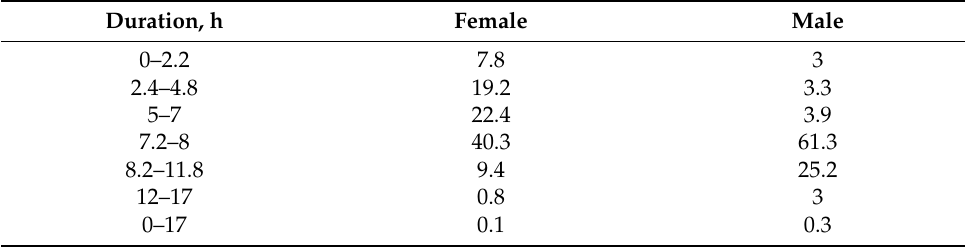
Table A3. Probability distributions of work durations by